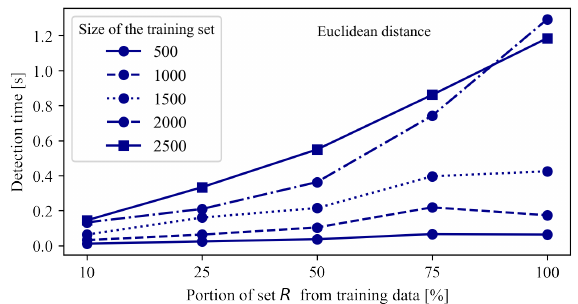
Figure 10. Anomaly detection time of the MLM using Euclidean distance varying size of the training set and proportion subset R .